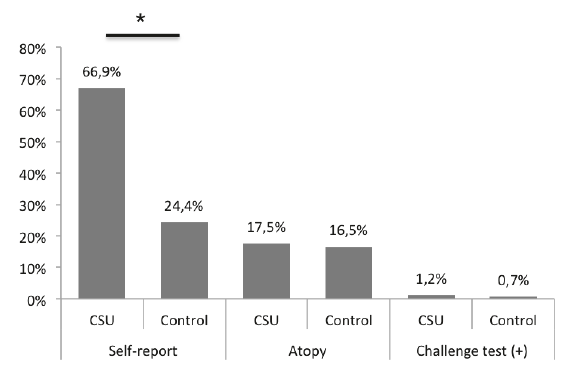
Figure 1: Self-report, sensitization, and challenge test in CSU and control group. Frequency of food sensitization and food trigger by self-report and challenge test to any food. Prevalence of Self-report, sensitization, and positive challenge test. Challenge test was done on 164 patients with CSU and 38 control subjects. The prevalence was calculatedforthetotalnumberofpatientsineachgroup(CSUgroup 245, control group 127).